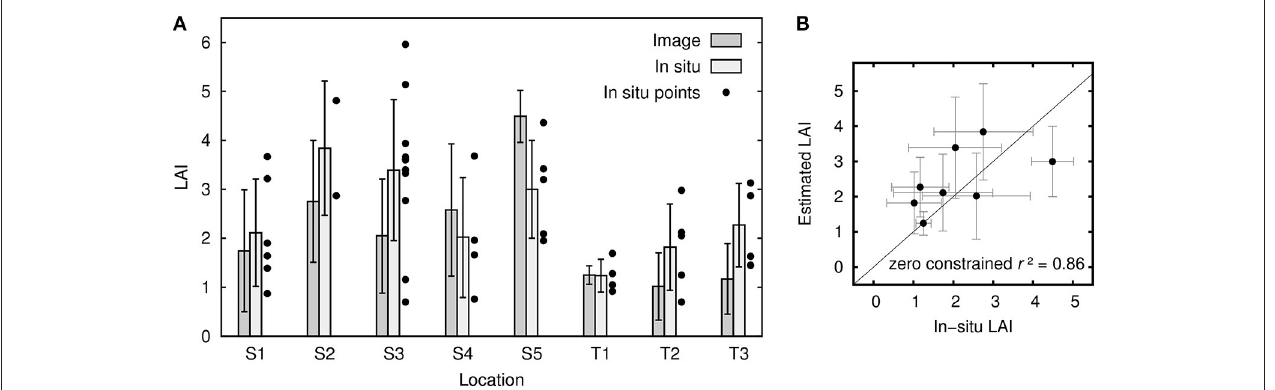
FIGURE 12 | (A) Leaf area index as estimated from imagery compared to in-situ data, for the five sites dominated by Syringodium (S1-S5) and the three by Thalassia (T1-T3). Bars show mean and standard deviation for in-situ data points and for a 4-pixel window around those points. The number of pixels contributing to each bar varies from 71 to 170. The individual data points at each location are plotted to show the variation that exists at each location. (B) Scatterplot of LAIs from in-situ data and 4-pixel window imagery estimates, i.e., the same information as in the bars in (A)